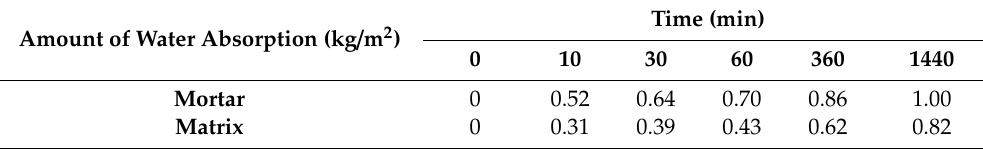
Table 4. Water resistance